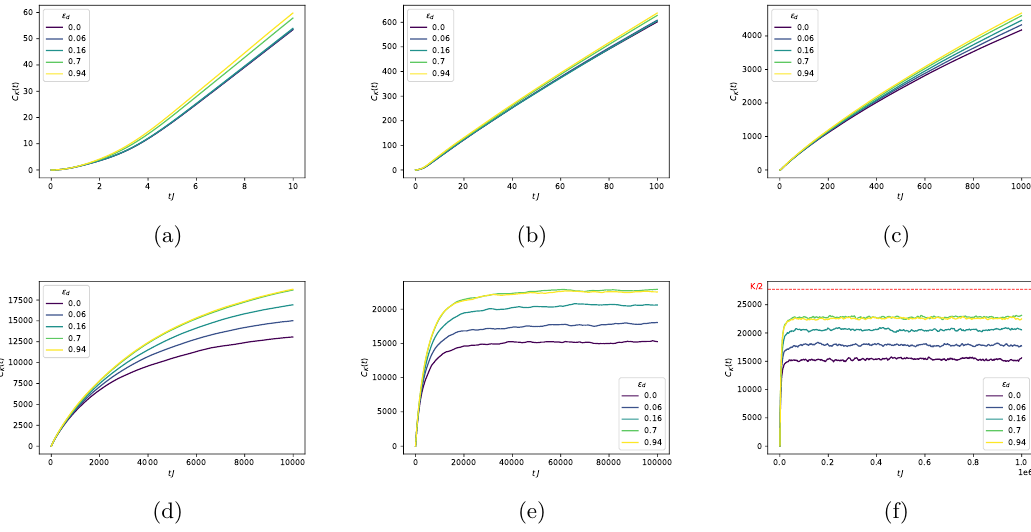
Figure 6. Results for the time-dependent profile of K-complexity at increasing time scales, for the same system of figure 4b. The Hamiltonian is H M = 6 , P = +1 sector with J zz = 1 . 1 , and the operator is O = S z Krylov space dimension for this setup is K = 55461 which equals the upper bound for the Krylov space dimension. The final plot shows the saturation values of K-complexity, with the value of K/ 2 shown for